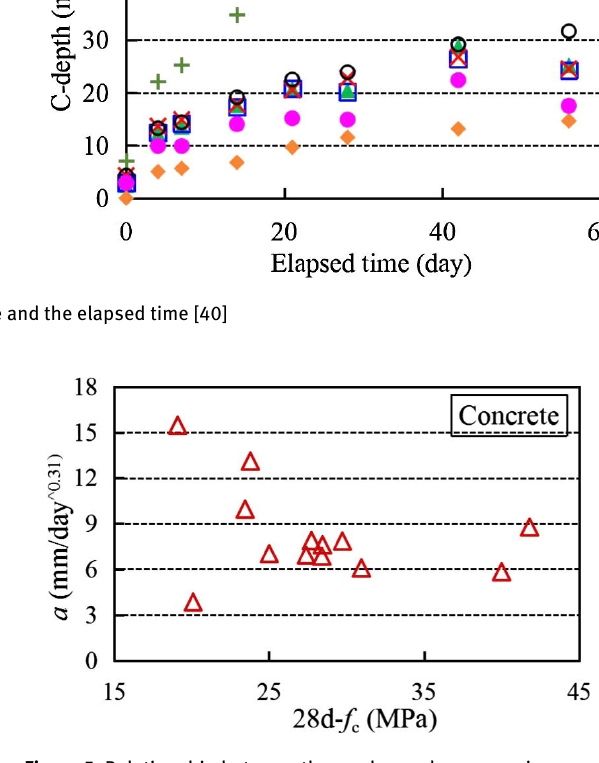
Figure 5: Relationship between the a value and compressive strength